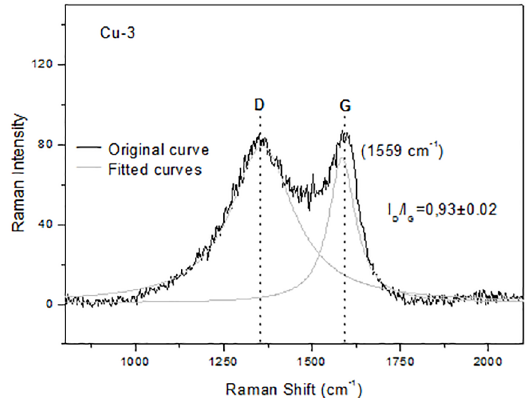
Figure 4. Raman spectrum of